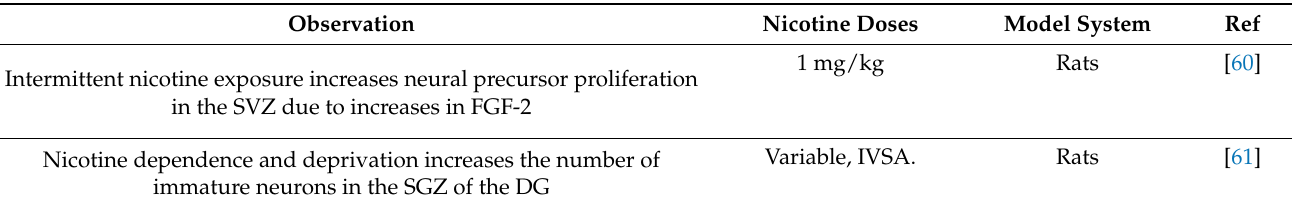
Table 2. Summary of nicotine-related increases in NSC